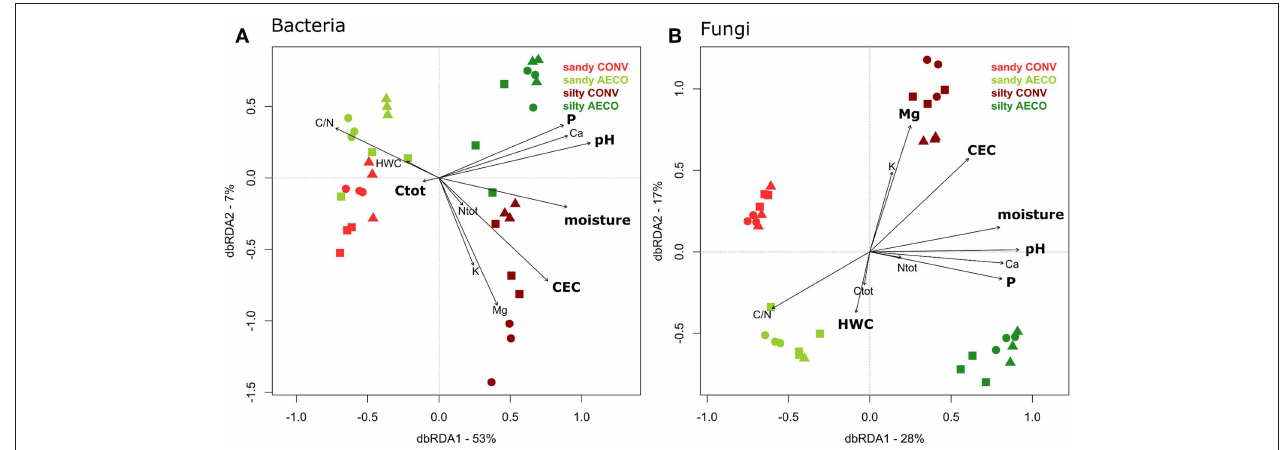
FIGURE 4 | Distance-based redundancy analysis representing the relationship between change in soil properties (represented by the arrows) and (A) bacterial and (B) fungal β -diversity. The variance explained by the axes is given in parentheses and represent the variance explained by all the physical and chemical parameters provided by the arrows. Agricultural management types are colored coded with red (conventional, CONV) and green (agroecological, AECO). Light colors represent the sandy site; dark colors represent the silty site. The symbols represent the pairs: squares, samples belonging to pair n ◦ 1; circles, pair n ◦ 2; triangles, pair n ◦ 3 (see Supplementary Figure 1 ). The parameters in bold represent the best descriptors as assessed by the DistLM provided in Table 1C